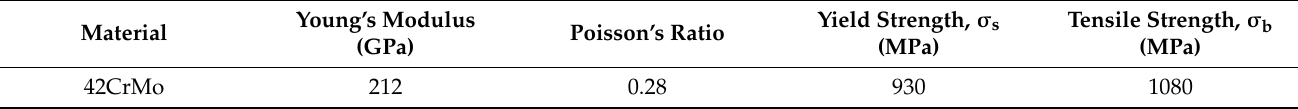
Table 1. Material mechanical properties of